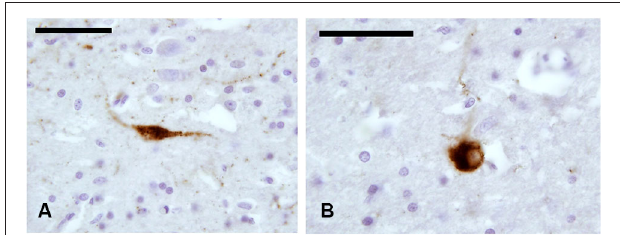
FIGURE 5 | SOM-ir fibers and neurons in the claustrum . (A–B) Images from paraffin-embedded sections. Scale bars etc.